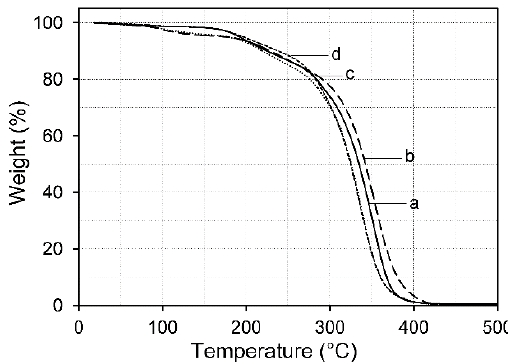
Figure 10. Thermogravimetric analysis of ( a ) PDEGMA; ( b ) POEGMA; ( c ) poly(OEGMA- co -DEGMA) 50:50 mol ratio; and ( d ) poly(OEGMA- co -DEGMA) 24:76 mole ratio.